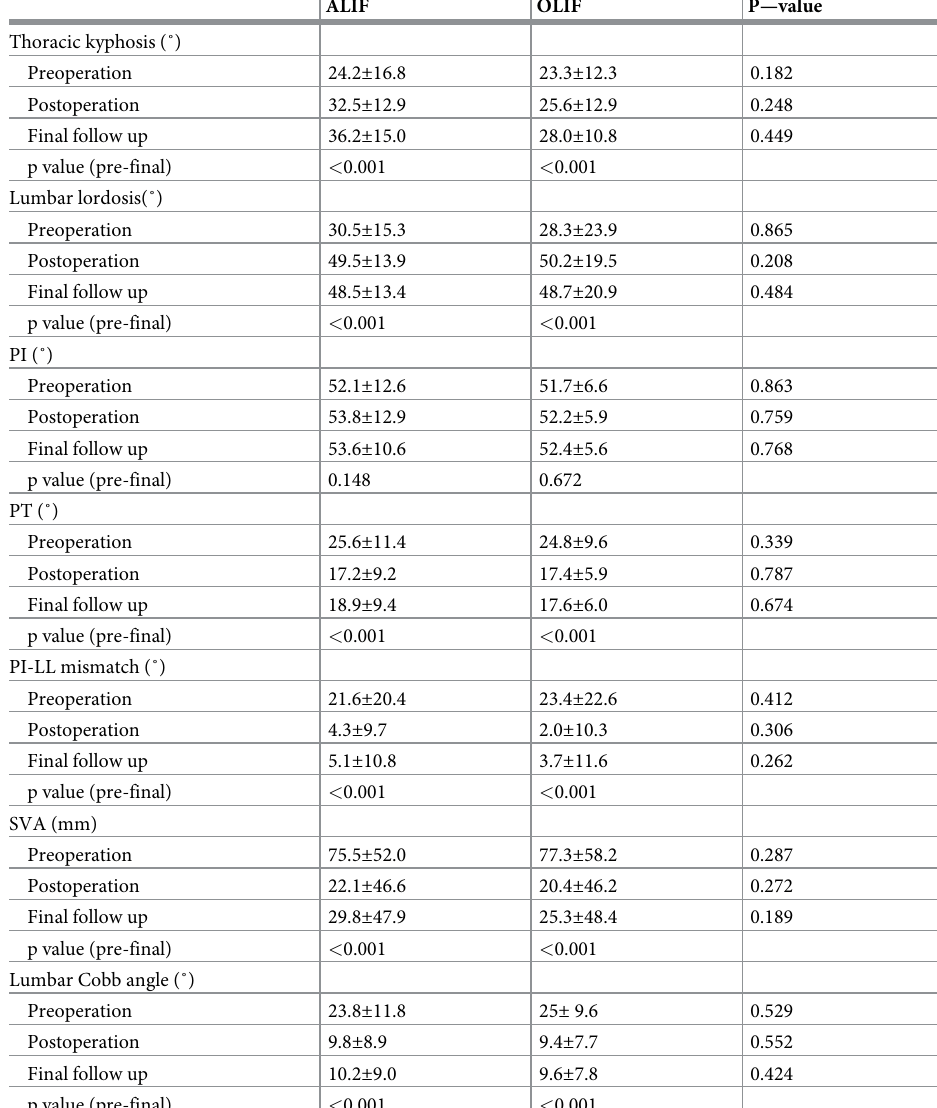
Table 2. Comparisons of sagittal and coronal radiographic data between the two